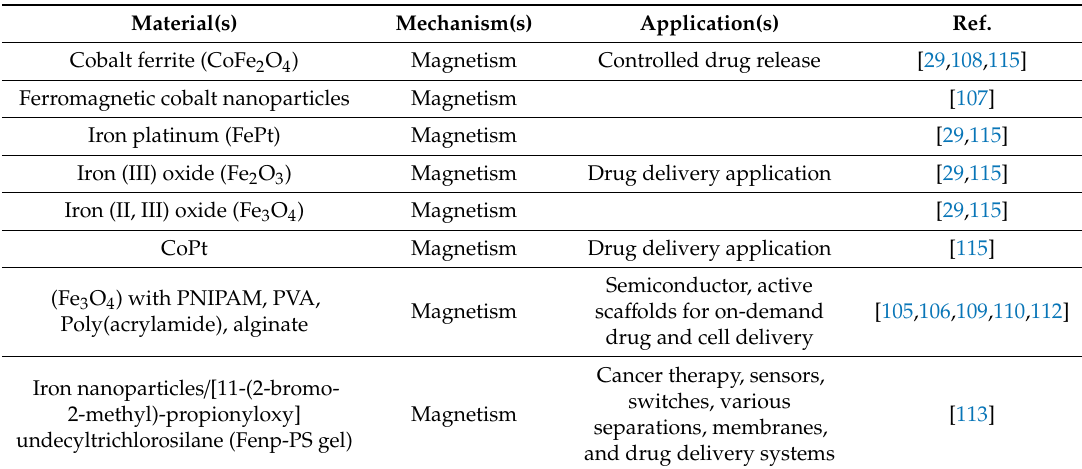
Table 4. Overview of the experiments on 4D (bio-)printing and other manufacturing approaches using magnetism as a predefined